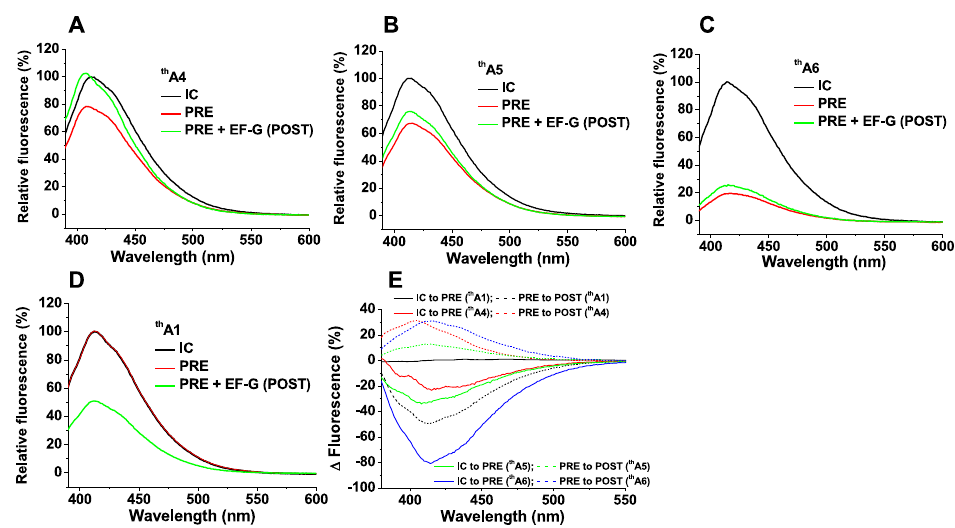
Figure 2. Activities of th A-containing mRNAs in complex formation. ( A ) 70SIC formation, measured as fMet-tRNA fMet co-sedimented per mRNA added: ribosomes, 1.0 mM; mRNA 0.5 mM; ( B ) Normalized PRE complex formation, with background in the absence of mRNA subtracted: ribosomes, 0.8 mM; ( C ) Normalized POST complex formation: ribosomes, 4.8 mM. Ranges shown are ± average deviation. Control experiments were performed, as indicated, with either no added mRNA, or with added unmodified mRNA. Values reported in ( B ) were normalized to the value obtained for unmodified fMKFR mRNA after subtraction of background obtained with no mRNA. Values reported in ( C ) were obtained following the previously published procedure for th G5 [28] and normalized to the value obtained for unmodified fMKFR mRNA.